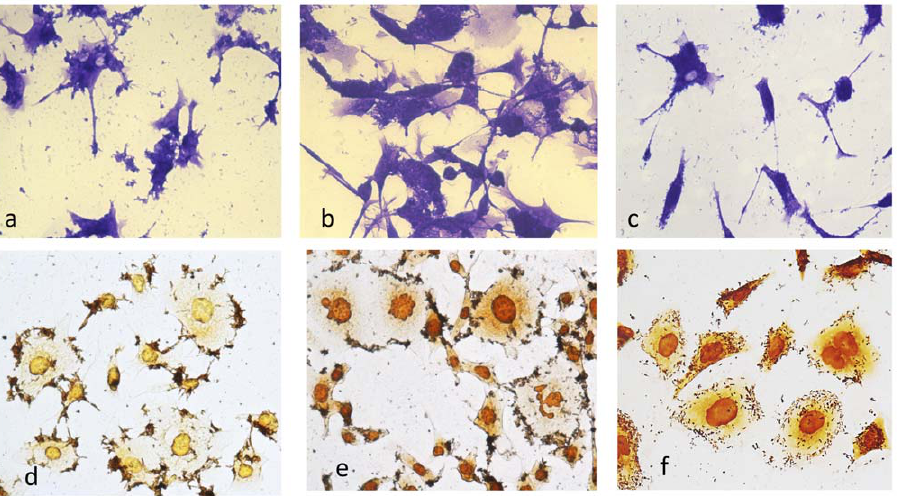
Figure 7. Activity of H.pylori strains from Mexican native groups on epithelial gastric AGS cells. We tested the activity of the Huichol strain 368H and of the Otomi 23O on AGS cells after 24 hs of co-culture, and stained with Giemsa: a) AGS incubated with 368H, b) AGS incubated with 23O, c) AGA incubated with a CagA ( + ) strain from a patient with DU. The pattern of adherence was monitored after 3 hs of co-culture, and stained with Whartin Starry: d) AGS incubated with 368H, e) AGS incubated with 23O, f) AGS incubated with the cagA( + ) DU patient. All images were taken at a 40X magnification.